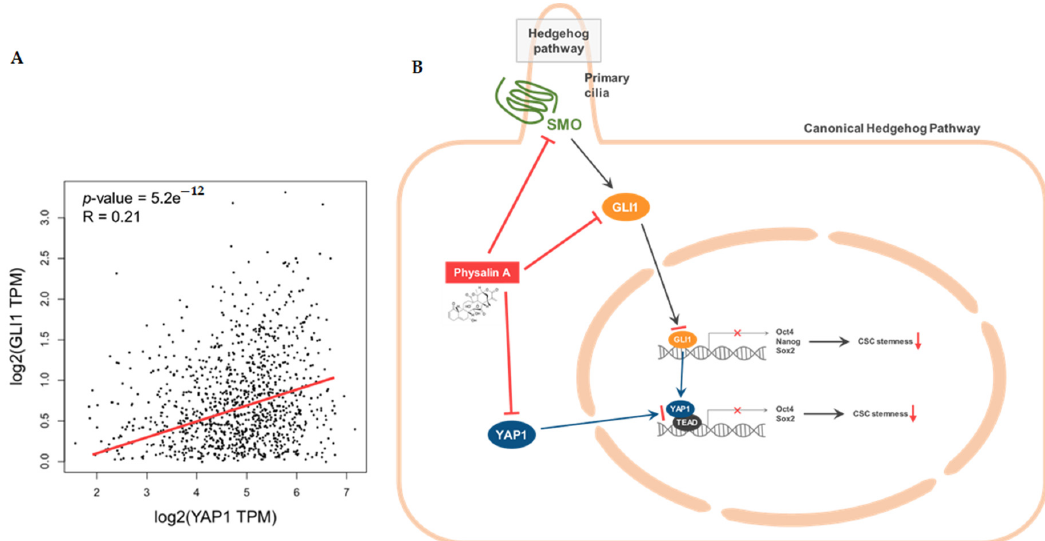
Figure 7. Relationship between GLI1 and YAP1 and the proposed model for physalin A-induced CSC death. ( A ) Scatter-plot of GLI1 and YAP1 expression in breast cancer patients (based on publicly available TCGA data). Spearman’s correlation coefficient and p -values are shown in this analysis. ( B ) The proposed schema suggests that physalin A regulates the canonical Hedgehog signaling pathway, induces down-regulation of YAP1, and inhibits BCSC. GLI1 also regulates the expression of YAP1. Inhibition of GLI1 and YAP1 contributes to the inhibition of BCSC formation.